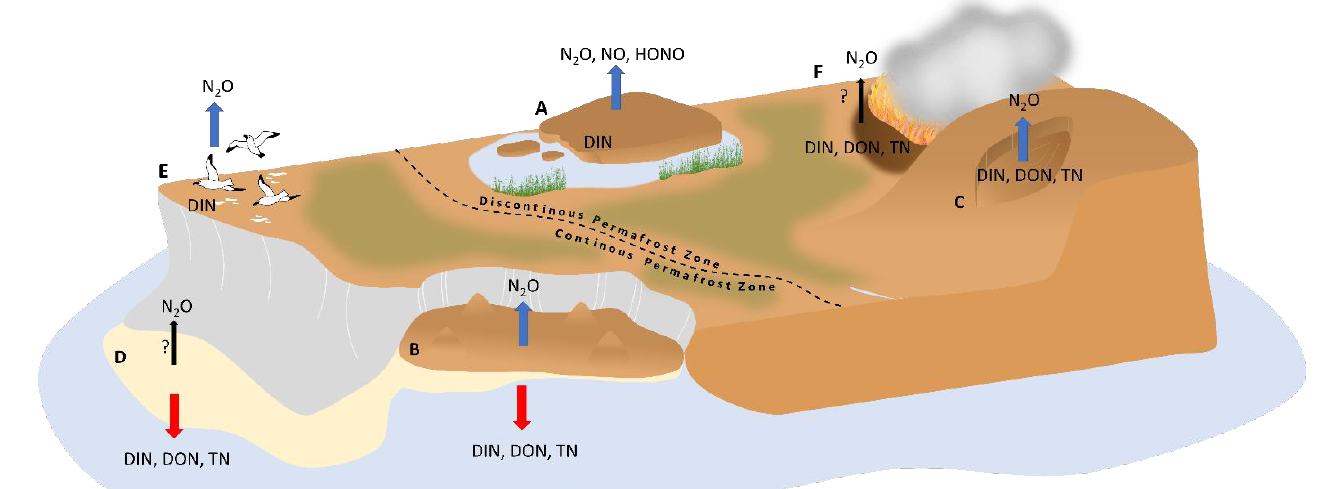
Figure 4. Hotspots of high N availability in a schematic permafrost landscape of a tundra ecosystem with ( A ) permafrost peat plateaus and palsas with bare peat surfaces in the discontinuous permafrost zone; hillslope thermokarst landscapes such as ( B ) retrogressive thaw slump in the continuous and ( C ) thermo-erosion gully in the discontinuous permafrost zone, ( D ) alluvial soils in the transition between terrestrial and aquatic ecosystems, and the occurrence of ( E ) animal-influenced soils and ( F ) wildfire throughout ecosystem. Blue arrows indicate known gaseous (N 2 O, NO, HONOH) and red arrows indicate lateral N (DIN, DON and TN) fluxes, black arrows indicate probability of N 2 O loss. N form without arrow describes enrichment in soil. DIN = dissolved inorganic, DON = dissolved organic nitrogen, TN = total nitrogen, ? = the N 2 O emission is largely